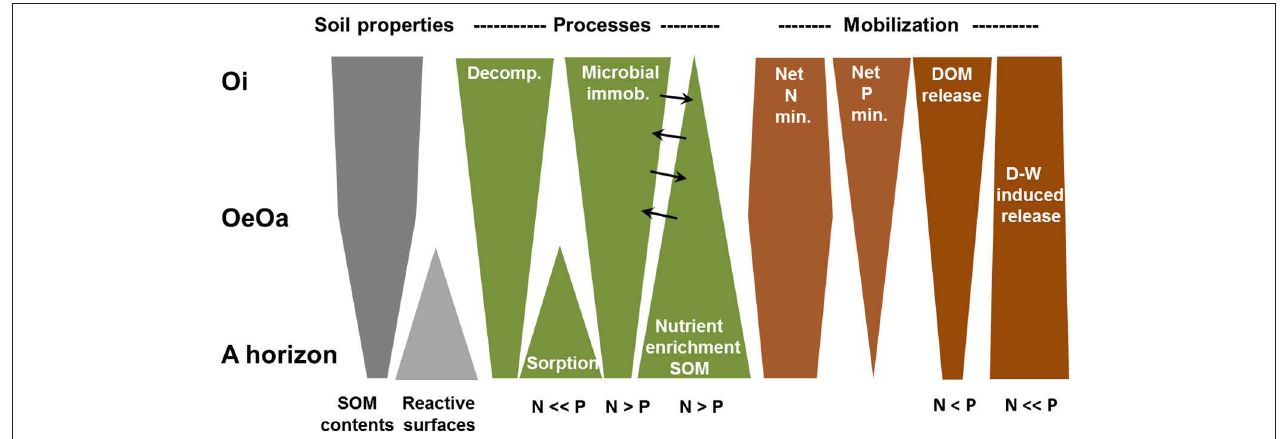
FIGURE 9 | Schematic representation of processes leading to a divergent release of C, N, and P in the Oi, Oe-Oa, and A horizons of forest